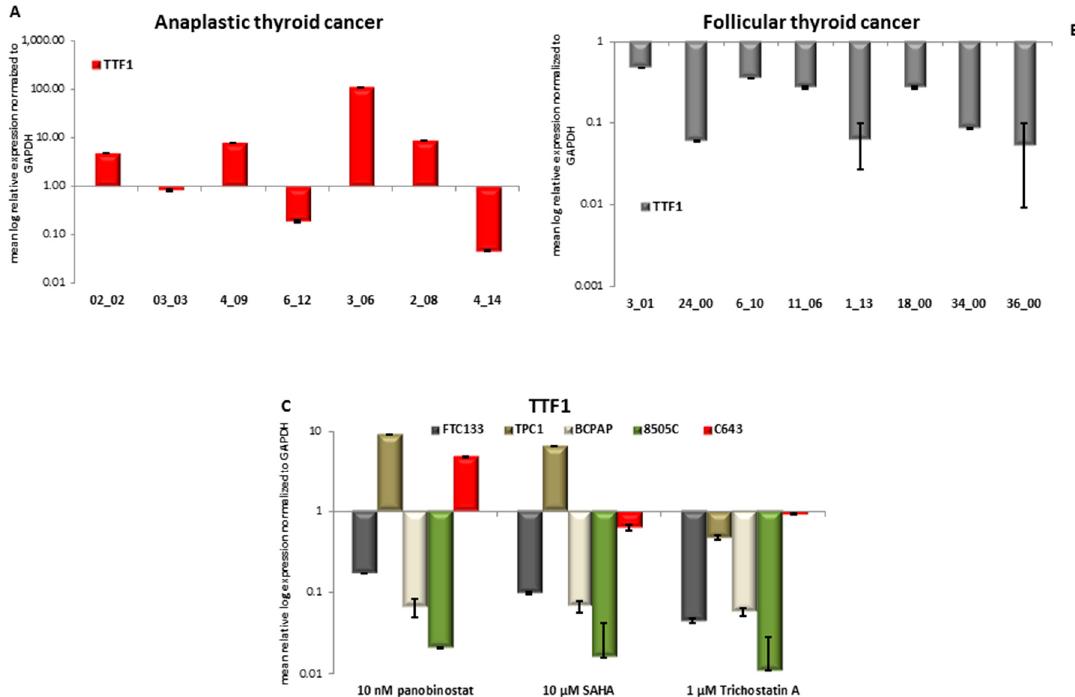
Figure 7. Expression of TTF1 in anaplastic thyroid cancer (ATC), Follicular thyroid cancer (FTC), and thyroid cancer cells treated with deacetylase inhibitors. RT-qPCR analysis of TTF1 transcript level in ATC ( A ), FTC ( B ) and FTC133, TPC1, BCPAP, 8505C, and C643 cells ( C ) after 48 h of treatment with 10 nM panobinostat, 10 µ M SAHA and 1 µ M Trichostatin A. mRNA expression was normalized to GAPDH. Results are expressed relative to untreated controls set at 1.0. Shown are means ± SEM of three independent experiments performed in triplicates.